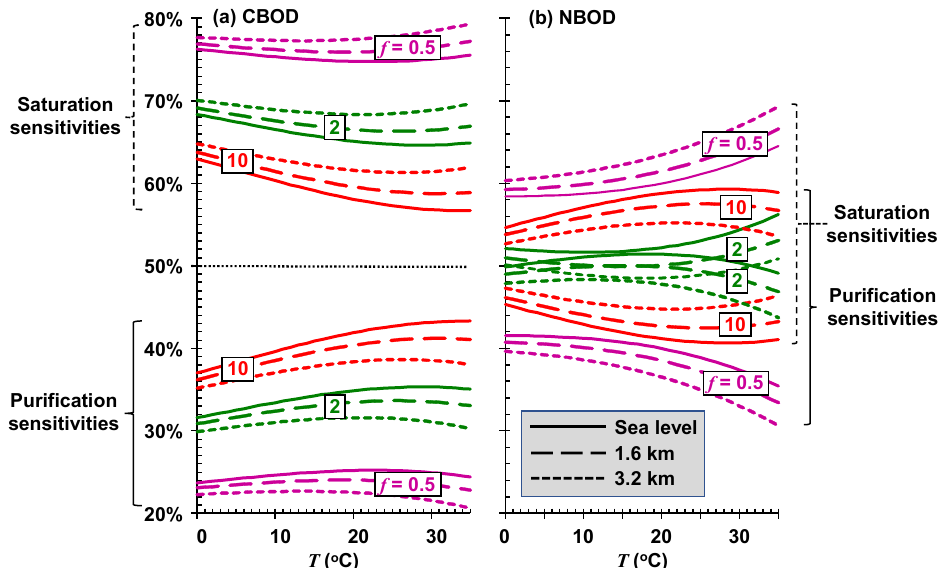
Figure 10. Percentage contributions due to the saturation and self-purification of the temperature sensitivity of the sustainable mixing-point concentration of ( a ) CBOD and ( b ) NBOD as a function of temperature for freshwater rivers at several elevations and self-purification constants ( f = 0.5: very stagnant; f = 2: large, moderate velocity streams; f = 10: high-velocity streams with rapids and